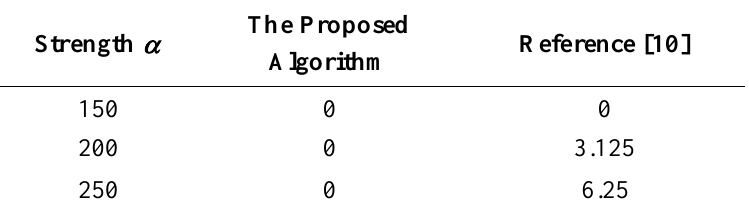
Table 1. Testing Results via White Noise Attack with various strength.